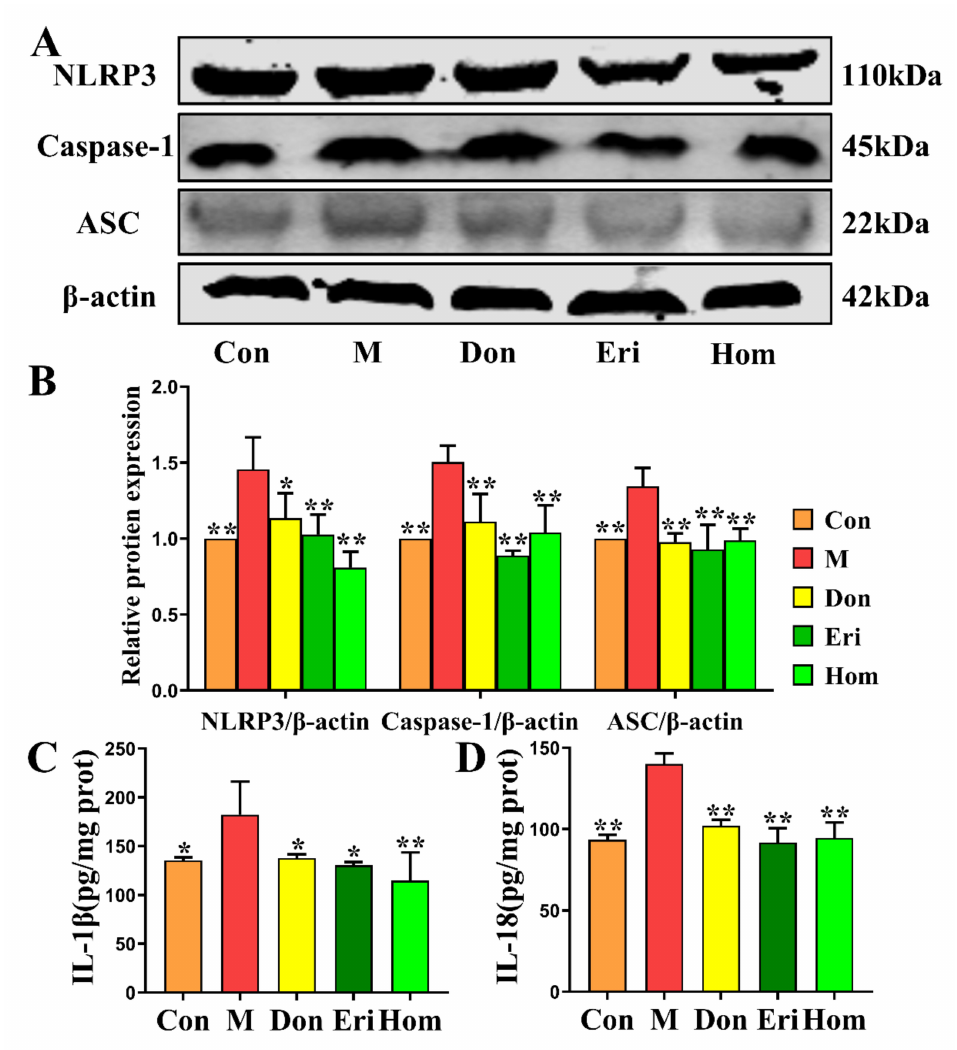
Figure 6. Eri and Hom inhibit NLRP3 inflammasome activation. ( A ) Expression of NLRP3, Caspase-1, and ASC proteins in brain tissue ( B ) Statistical analysis of relative expression of NLRP3, Caspase-1, and ASC. ( C , D ) Measure the levels of IL-1 β and IL-18 in the brain tissue according to ELISA kits. The data were expressed as the mean ± SD. n = 3 * p < 0.05, ** p < 0.01 compared with the M group. Con means the control, M means the model, Don means the donepezil, Eri means the eriodictyol, Hom means the